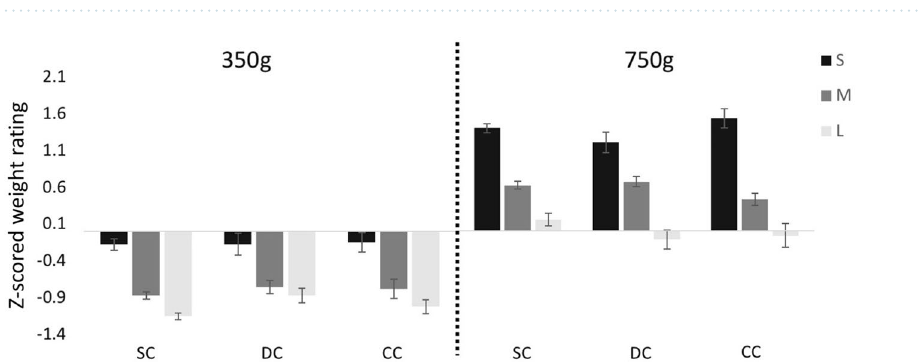
Figure 3. Experiment 1 (with visual and haptic size information); average z-scored weight ratings for the Small (S), Medium (M) and Large (L) cubes across the Sighted Control (SC), Developmental Cataract (DC) and Congenital Cataract (CC) groups, for the 350 g and 700 g weights (Experiment 1). Error bars depict standard error of mean